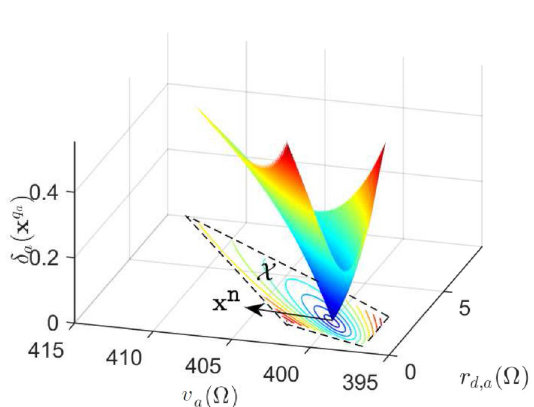
Figure 8. The signaling space X and the relative power deviation δ a ( q a ) in a two-unit system.